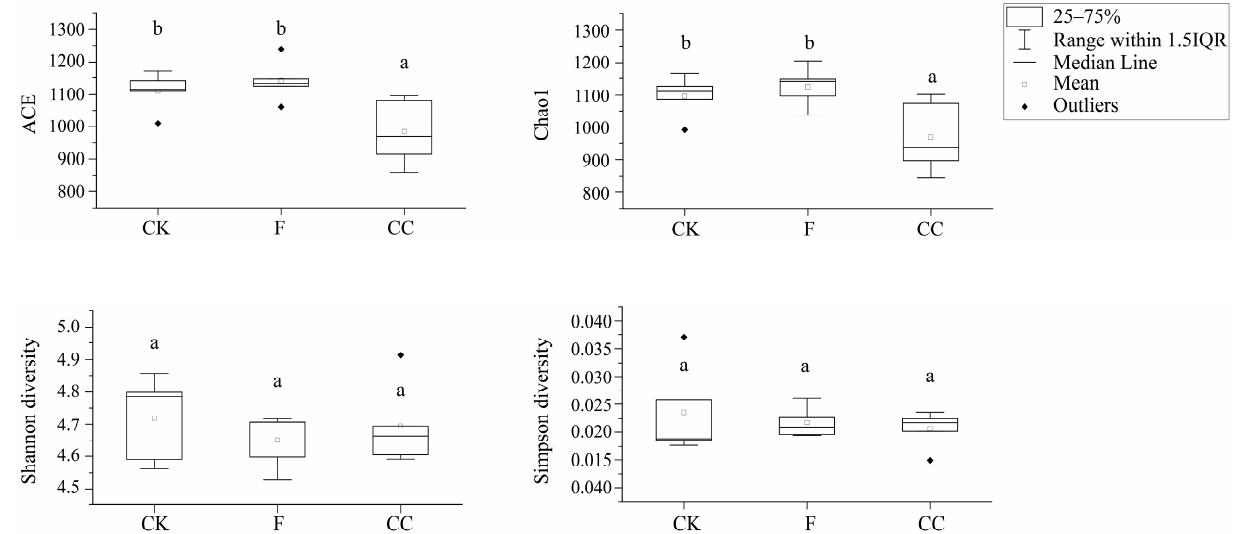
Figure 2. Box plot of alpha diversity indices of the fungal communities in tea nursery soil. Different letters indicate significant differences between the three treatments (control (CK), flooding (F) and calcium cyanamide (CC) at p < 0.05).